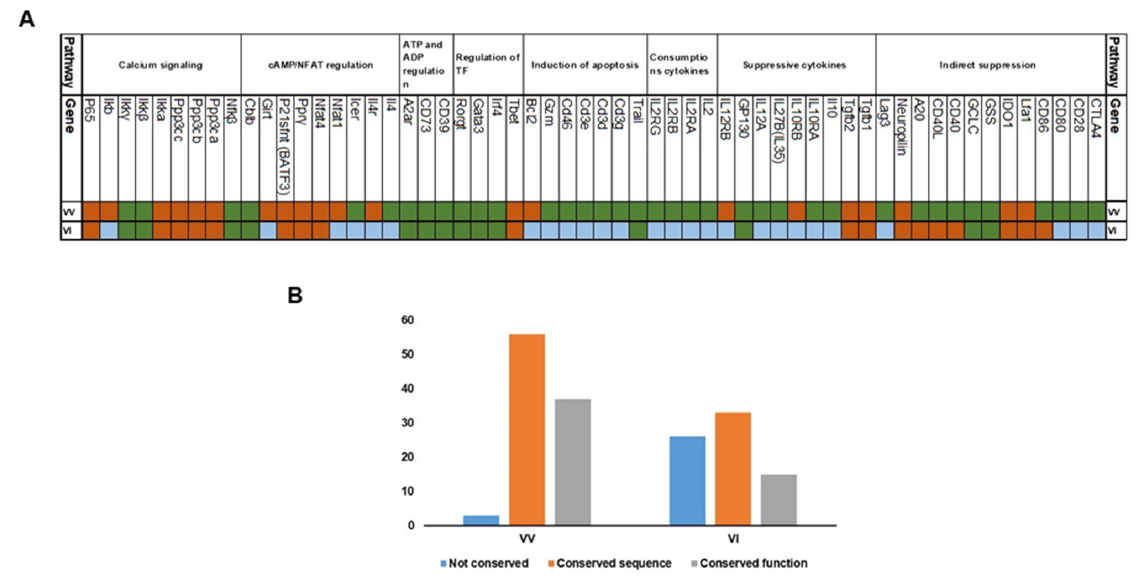
Figure 3. Analysis of literature reporting functional conservation of Treg suppressor mechanisms. ( A ) We compared 60 proteins for reported conservation between vertebrate–vertebrate (VV) and between vertebrates and invertebrates (VI) (green is conserved, red is non-conserved). ( B ) Percentages of functional conservation by category.